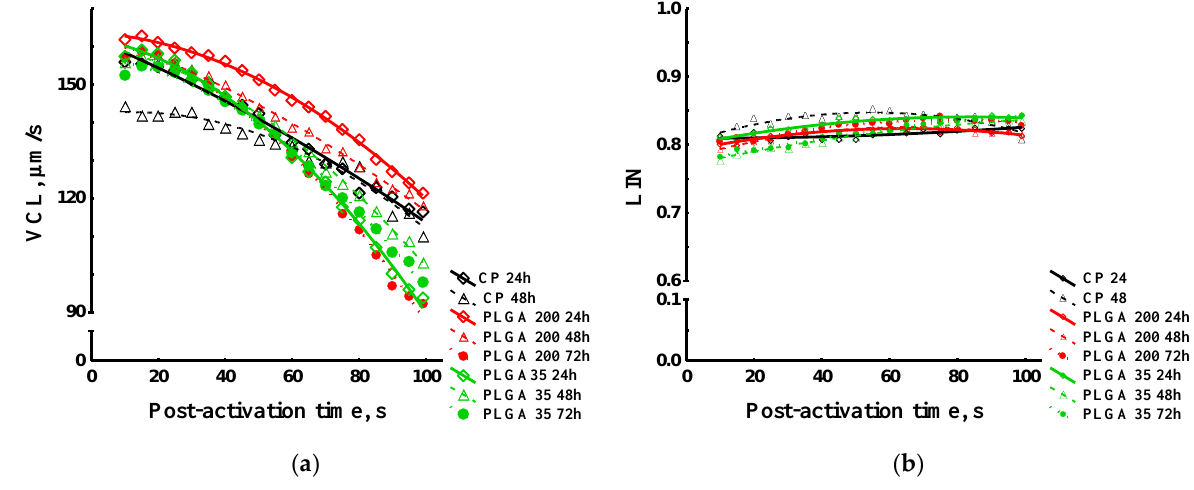
Figure 7. Kinematic parameters of sterlet spermatozoa obtained after hormone treatments. ( a ) VCL dynamics post-activa- tion. ( b ) LIN dynamics post-activation. Data are presented as mean (dots) and quadric polynomial regression lines. Ab- breviations: CP 24 h, CP 48 h-treatment by carp pituitary extract, dose 4 mg/kg, samples collected at 24 and 48 h post-